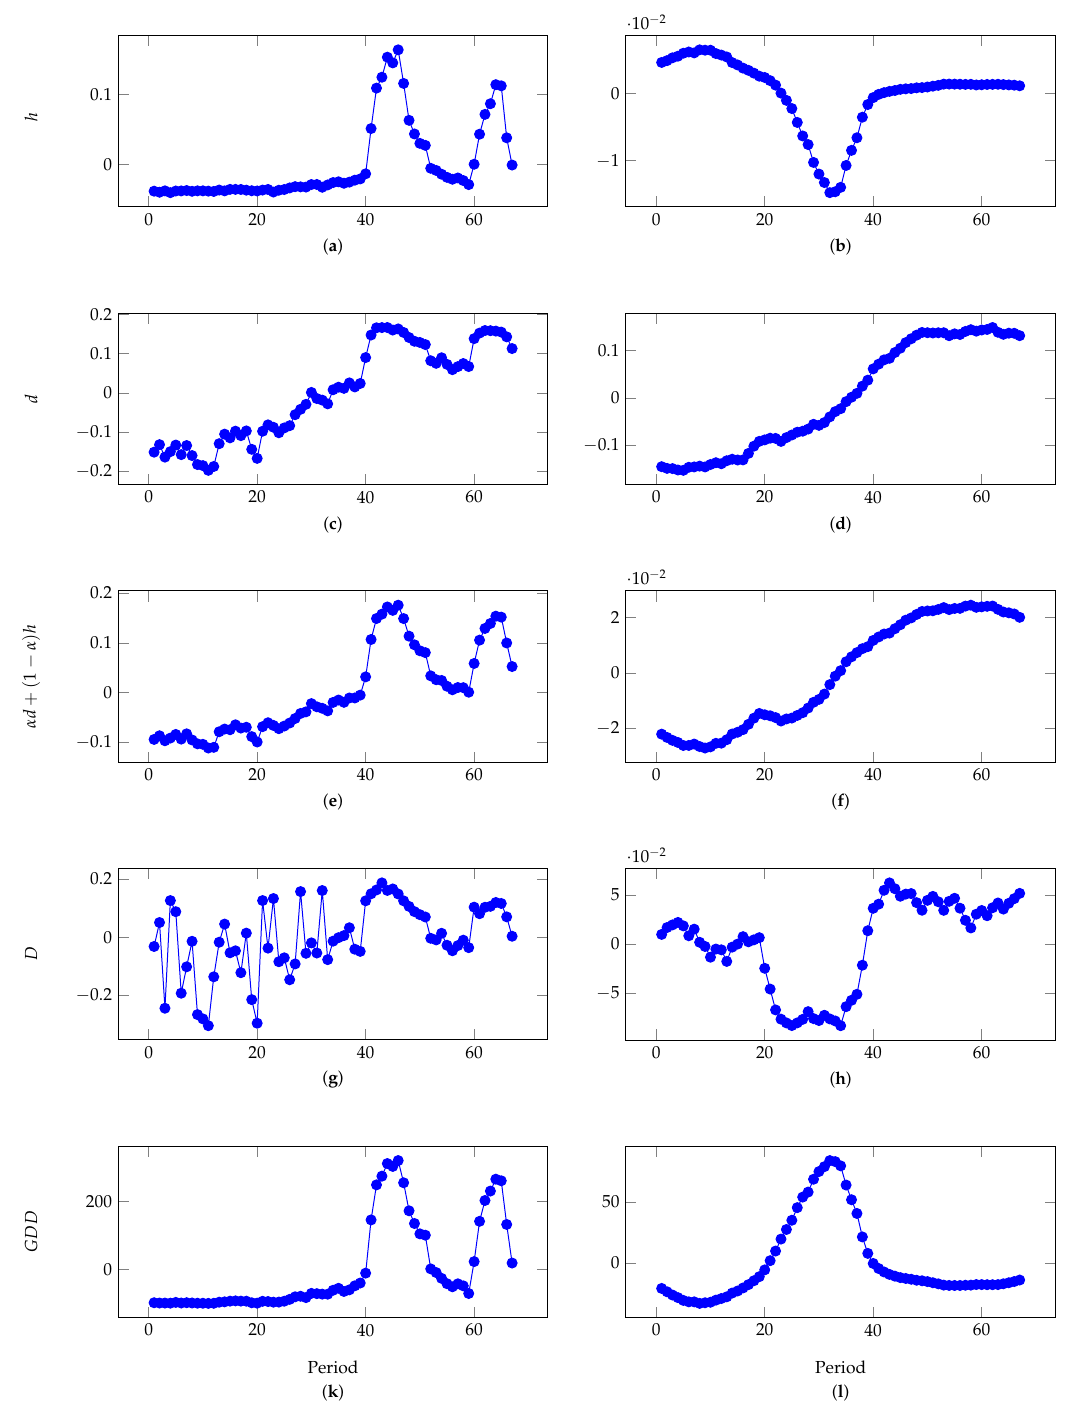
Figure 6. Graphic representation of the results of calculating the difference matrices between graphs. Figures ( a , c , e , g , k ) present the results of multidimensional scaling applied to the distance matrix between market graphs which is calculated using the Hamming distance, d -measure, l α -measure with α = 0.05, D -measure and GDD , respectively. Figures ( b , d , f , h , l ) present the results of multidimensional scaling applied to the distance matrix between company co-mention networks which is calculated using the Hamming distance, d -measure, l α -measure with α = 0.05, D -measure and GDD ,